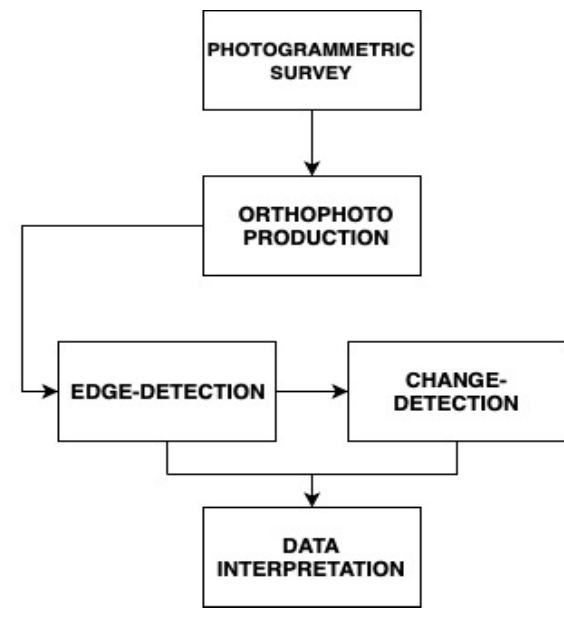
Figure 3. The workflow adopted in the